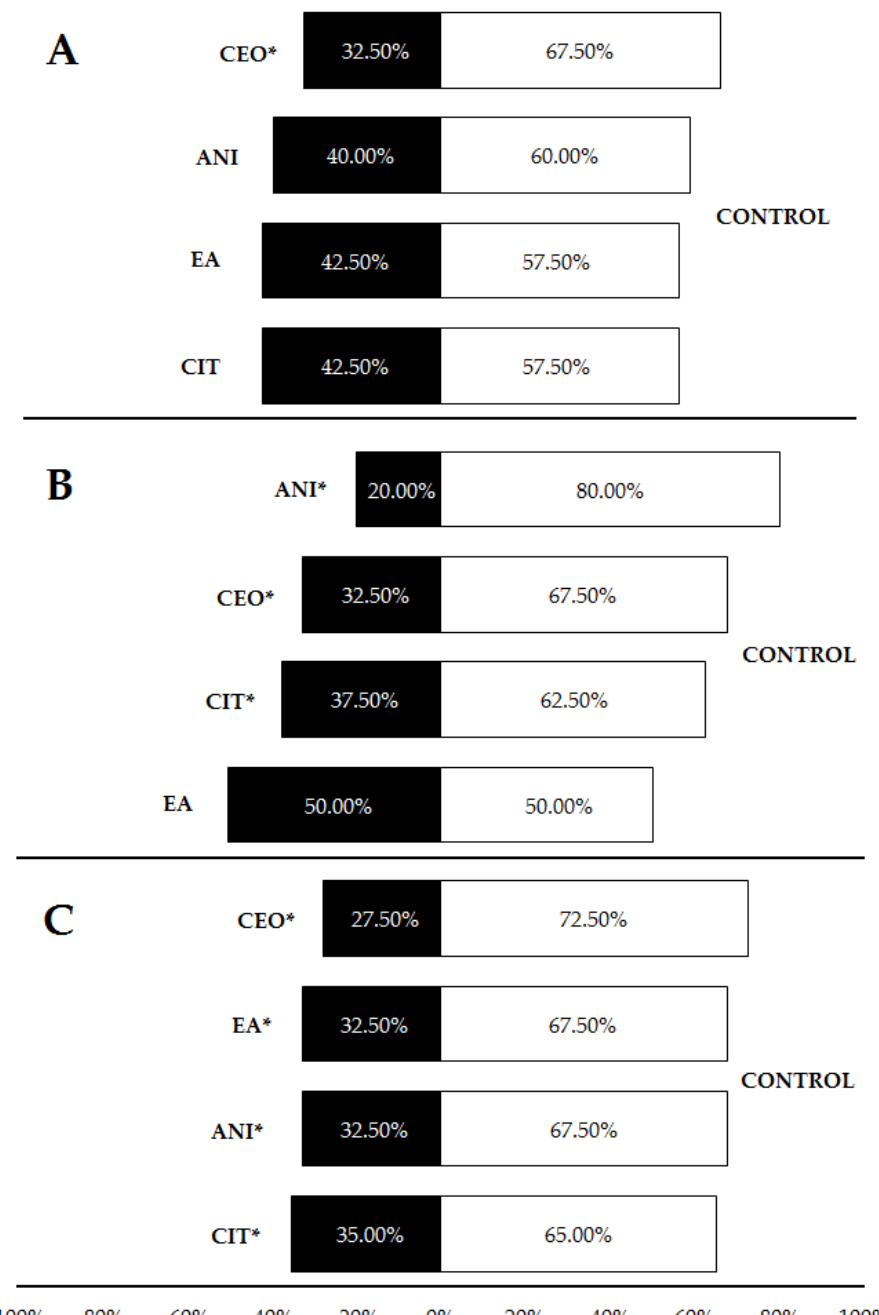
Figure 6. Percentages of Pheidole pallidula workers responding to each compound incorporated into plastic when offered simultaneously an odorless control (also in plastic) in the olfactory tests. In ( A ), compounds were incorporated into LDPE plastic at a concentration of 5%; in ( B ) and ( C ), compounds were incorporated into HDPE plastic at a concentration of 3% ( B ) and 5% ( C ). Asterisks (*) indicate significant differences between compounds and controls in each choice ( p ≤ 0.05). CEO: